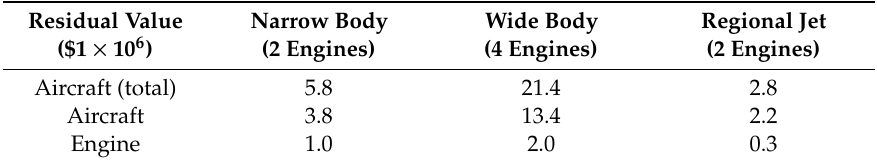
Table 5. Average residual value (2 engines for narrow body and regional jet, 4 engines for wide body) ( r residual = 10%) (2014